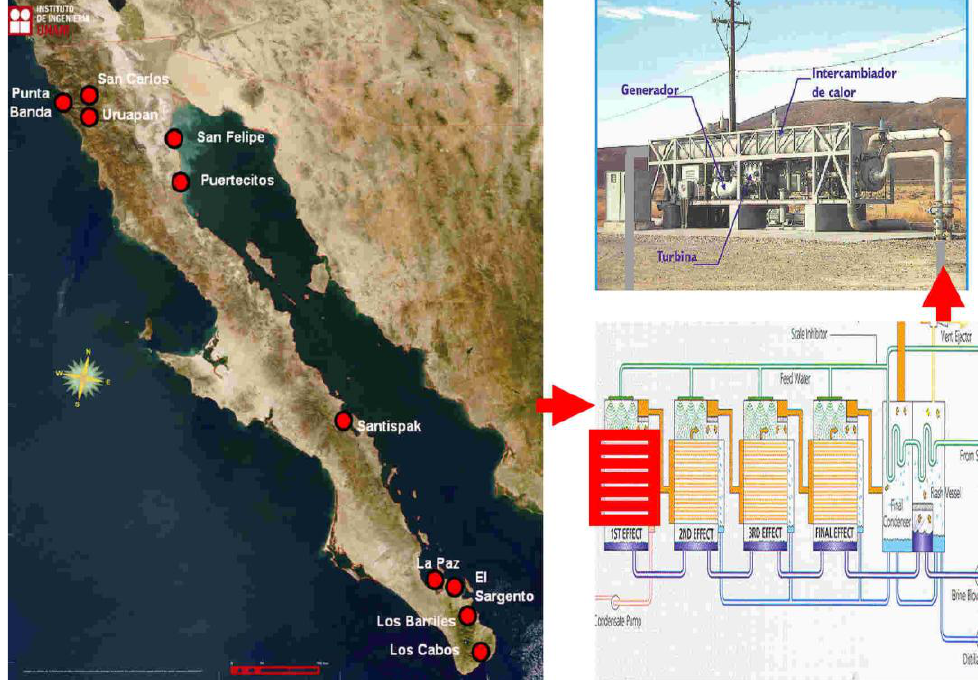
Figure 4. Left: Locations with hot sea water at 50 m depths in the Baja Peninsula in Mexico (red dots on map) with the Pacific Ocean on western side and the Gulf of California on the eastern side [46]; Upper right: Actual boiling or flashing effect (highlighted in red in previous schematic). (See also Table 1 and section 2 for further information about MED); Lower right: Schematic of multiple effects boiling/distillation (MED) (or flashing) thermal desalination system with first effect highlighted in